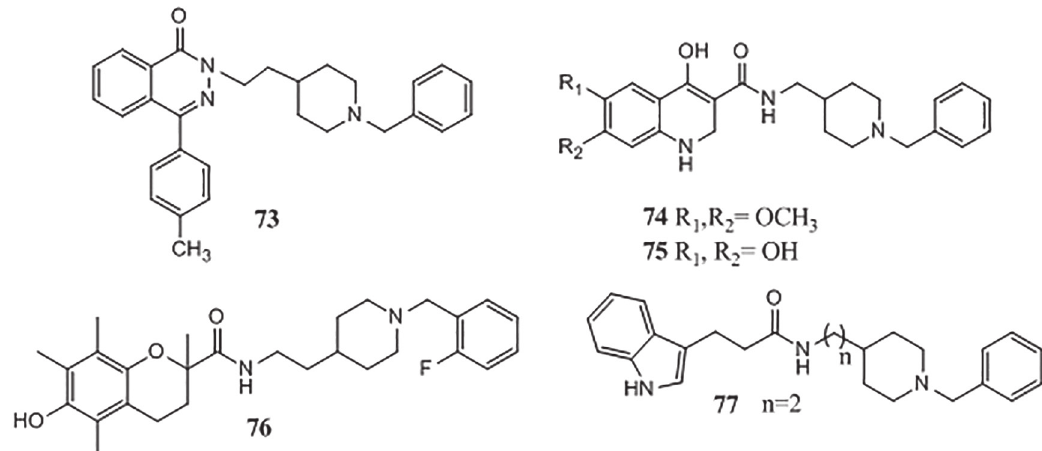
FIGURE 11 - Donepezil derivatives having condensed heterocyclic